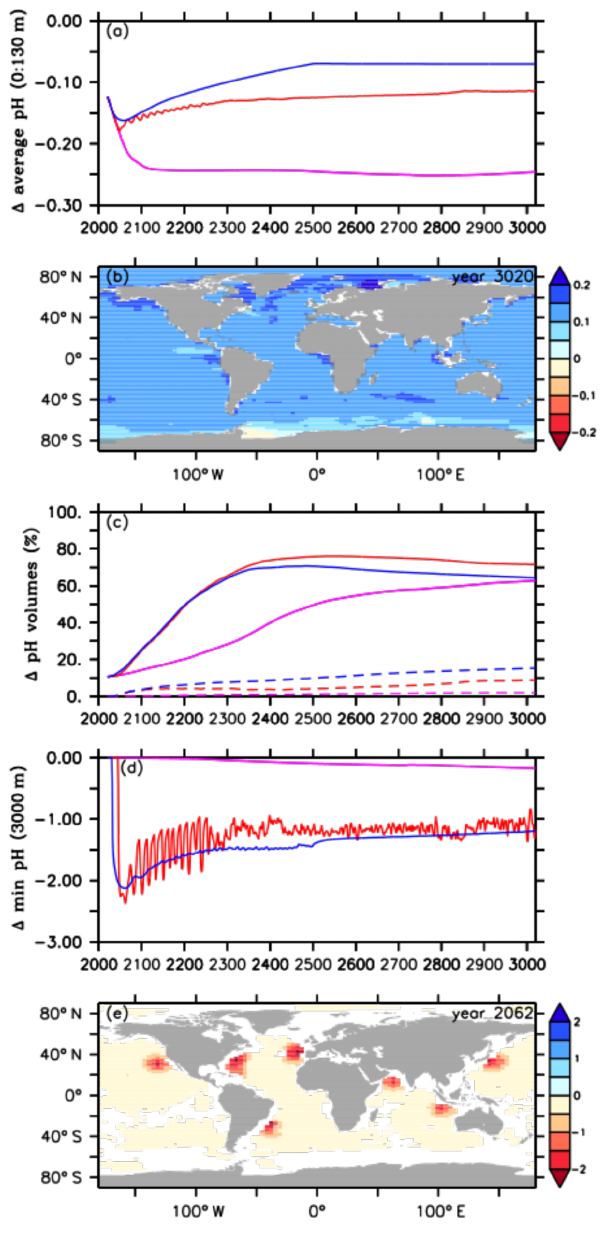
Figure 3. Comparison of pH values between the default RCP4.5 control run (purple lines), the A2 simulation (red lines), and the A3 simulation (blue lines) for (a) the average ocean surface pH (0 to 130m depth), (b) the difference in ocean surface pH, relative to preindustrial levels, between the A2 simulation and the default RCP4.5 control run in the year 3020, (c) pH volumes of the first ( ≤ 7 . 8 and ≥ 7 . 4, solid lines) and second categories ( < 7 . 4, dashed lines), (d) minimum pH values at 3000m depth, and (e) the differ- ence in minimum pH at 3000m depth between the A2 simulation and the default RCP4.5 control run in the year